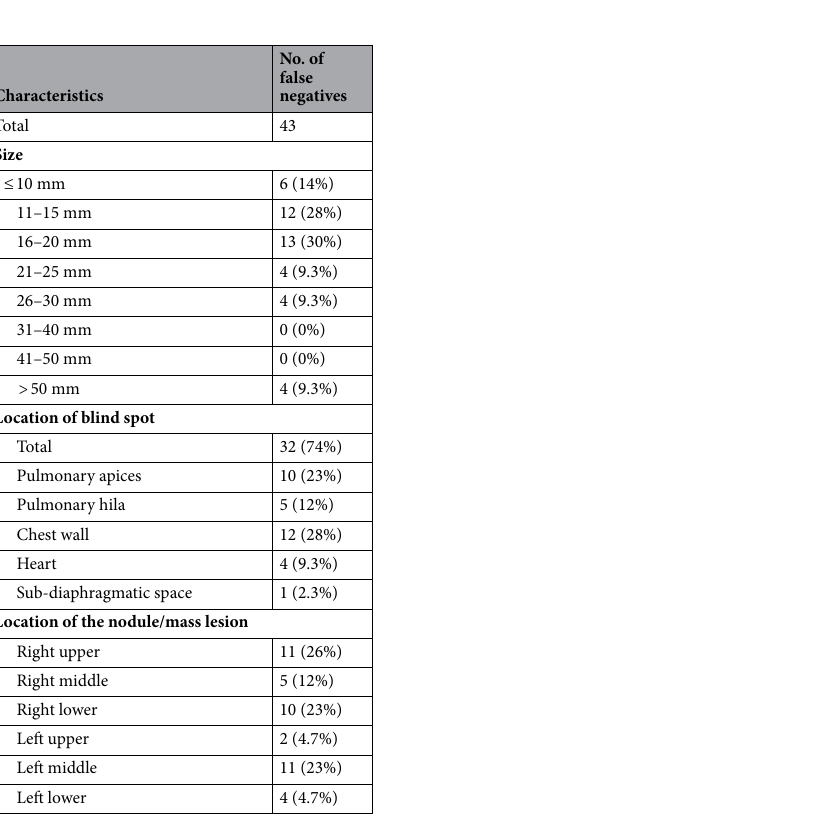
Table 4. False negative nodule/mass characteristics in the test